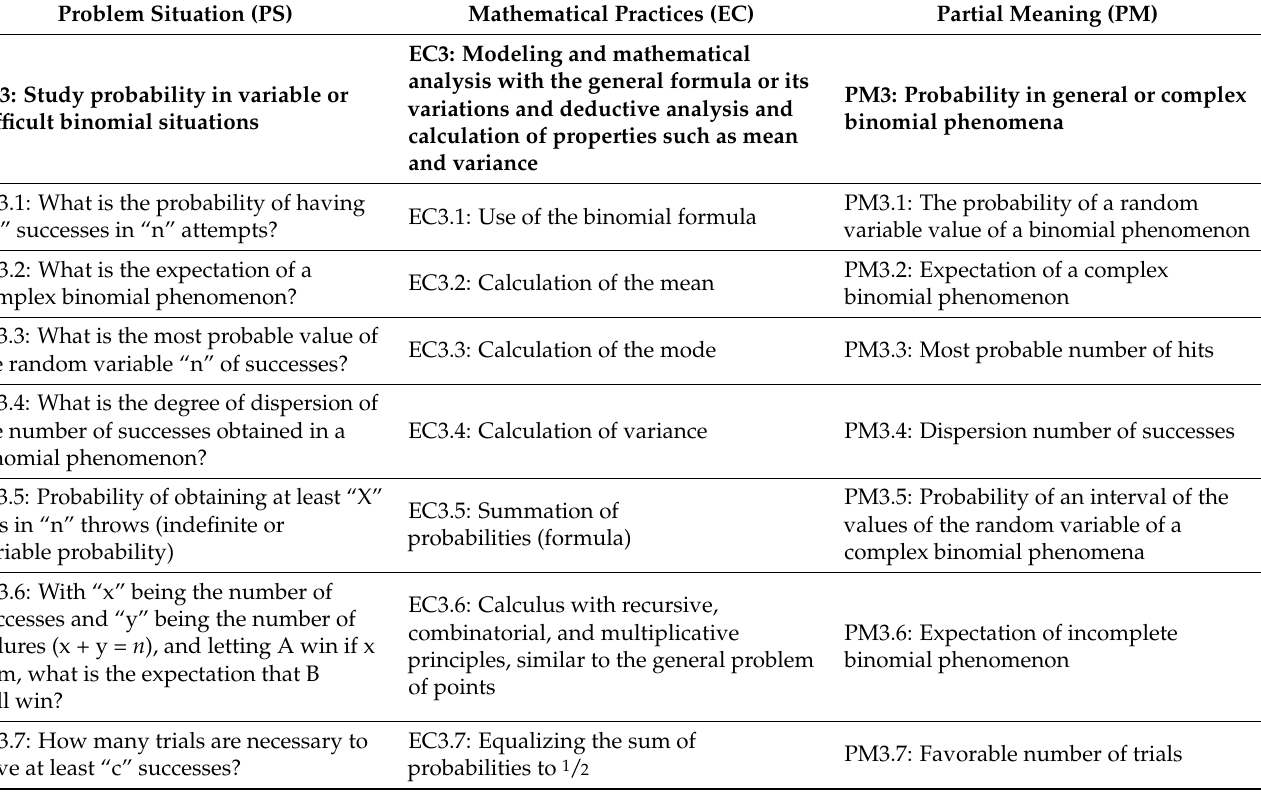
Table 6. Practice system for problems involving more complex or varying binomial